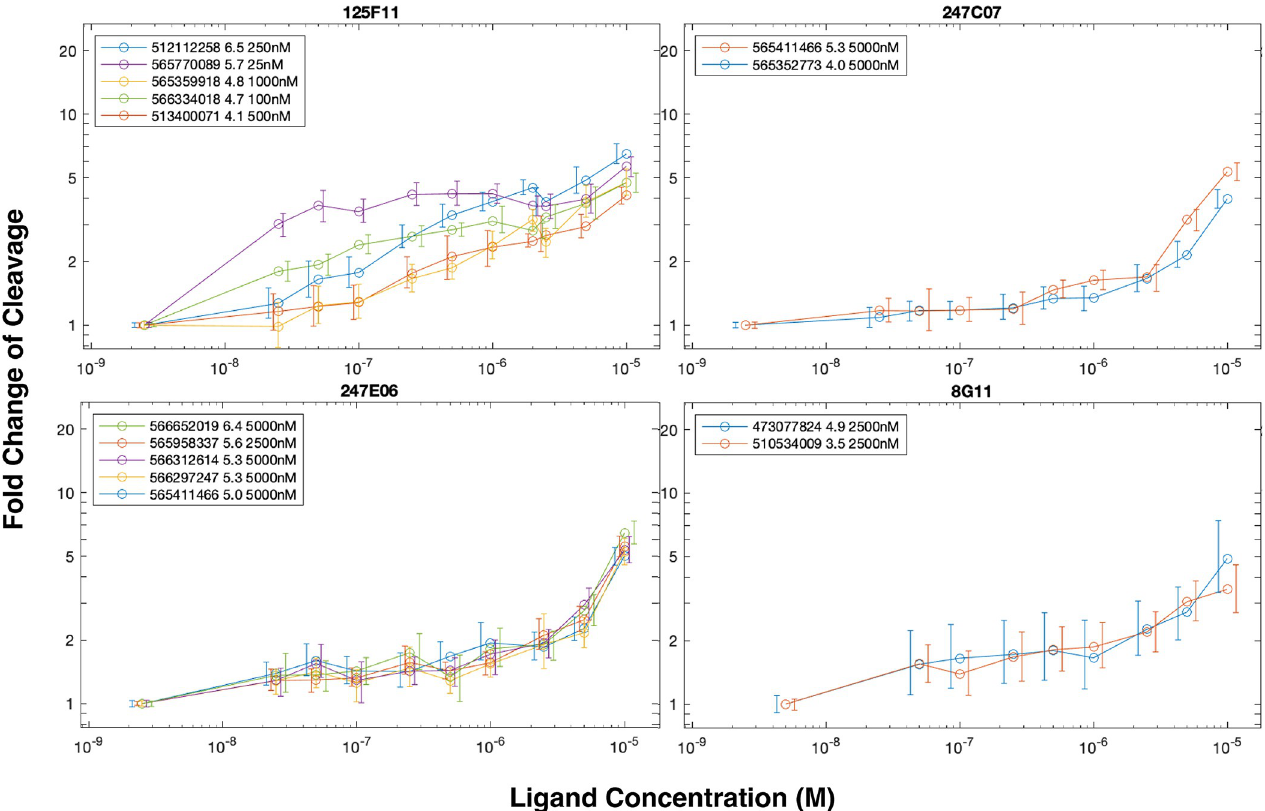
Fig 5. Biosensors demonstrate a range of sensitives. Fold change as a function of compound concentration is shown for selected aptamer-compound combinations that exhibited at least 3.5-fold change in cleavage at 10 μ M small molecule concentration. Error bars are 95% confidence intervals based on NGS read counts for single measurements at each concentration. Some measurements were made in parallel by combining up to 4 compounds in the same well, in which case only sequences that were not affected by the other compounds present are shown (based on single-target measurements at 10 μ M). Legend entries show the sequence IDs, fold change of cleavage at 10 μ M, and the minimum concentration measured that produces at least 2-fold change of